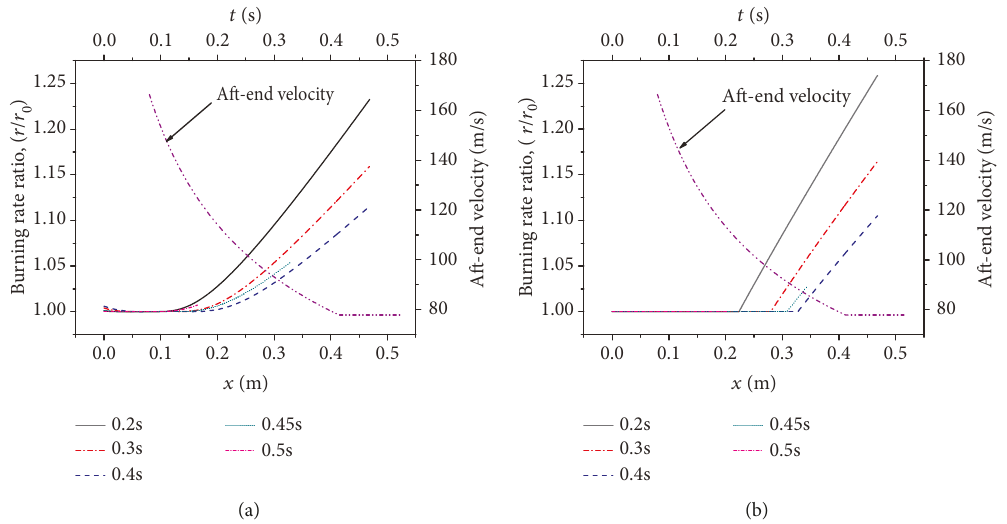
Figure 7: Local burning rate ratio and velocity of aft end in the inner channel at di ff erent times. (a) Computed with L-R expression. (b) Computed with Mukunda-Paul